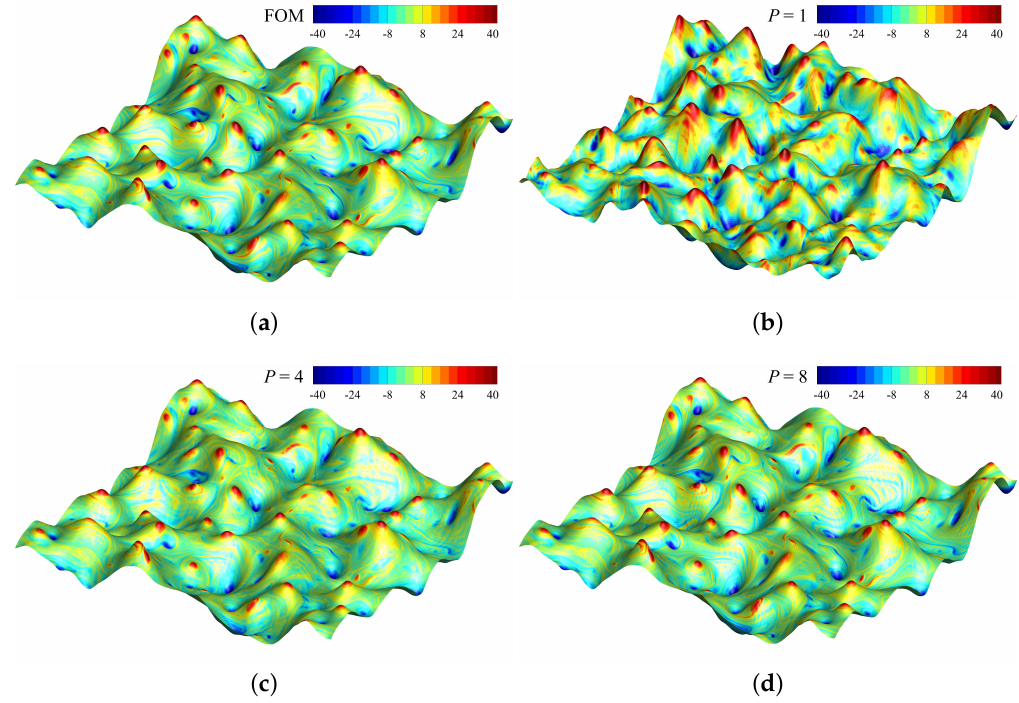
Figure 6. Predicted results at time t = 4 showing vorticity contours in color with the level of streamfunction as height. ( a ) Full order model (FOM), ( b ) ROM ( R = 16) with P = 1, ( c ) ROM ( R = 16) with P = 4, and ( d ) ROM ( R = 16) with P =